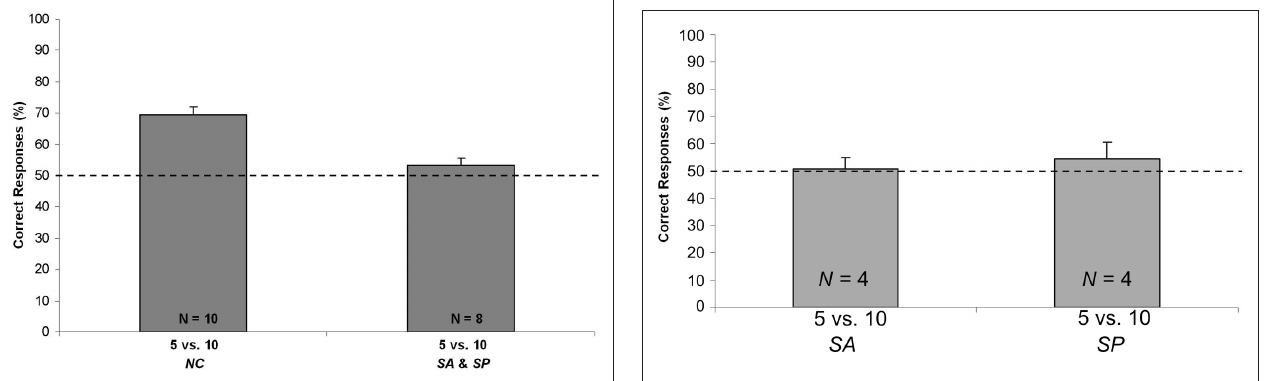
Figure 4 | results of exp. 2. Percentages of correct responses (group means ± SEM) shown by chicks of NC, SA, and SP conditions, that underwent the 5 vs. 10 test. The dotted line ( y = 50) represents chance level.